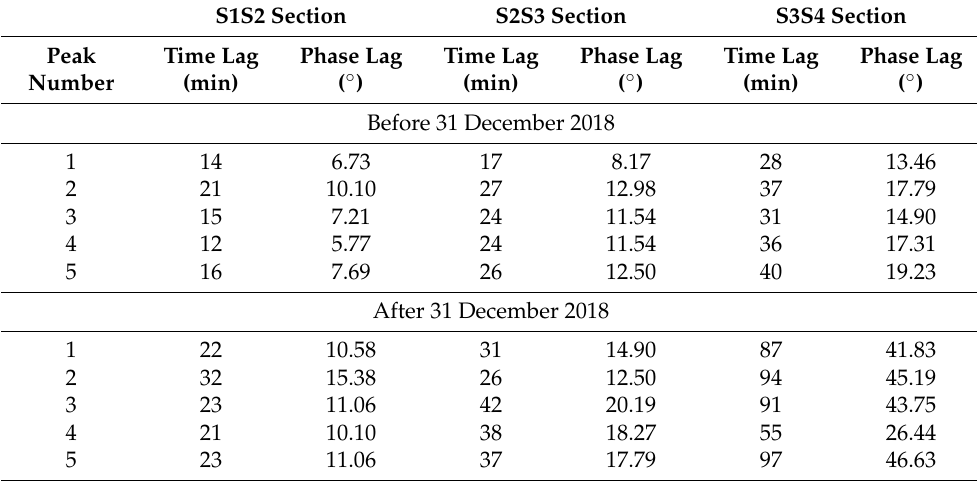
Table 1. Delays in time of salinity